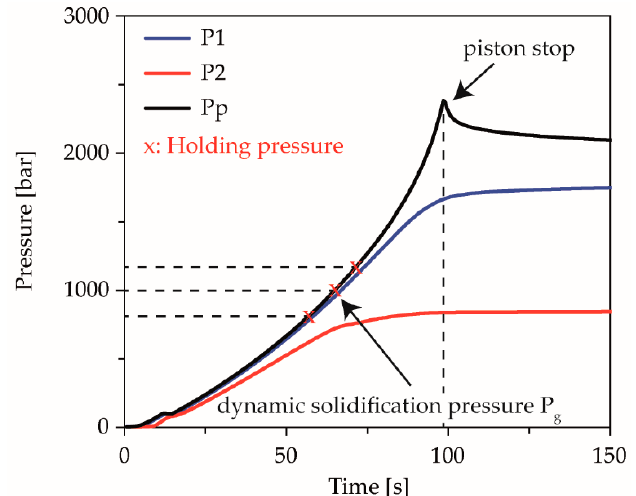
Figure 3. Illustration of the chosen holding pressure levels, calculated according to the master curve using the example of the performed limit experiment at 5.0 × 10 − 3 1/s and 240 °C.